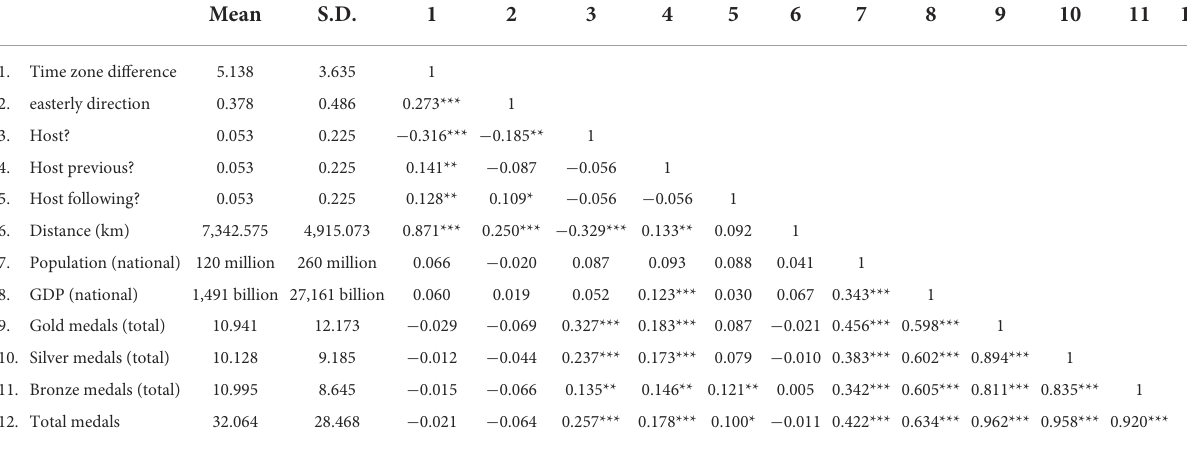
medal. Gold medals (total) : The number of gold medals won by a country. Silver medals (total) : The number of silver medals won by a country. Bronze medals (total) : The number of bronze medals won by a country. Total medals : The total number of medals won by a